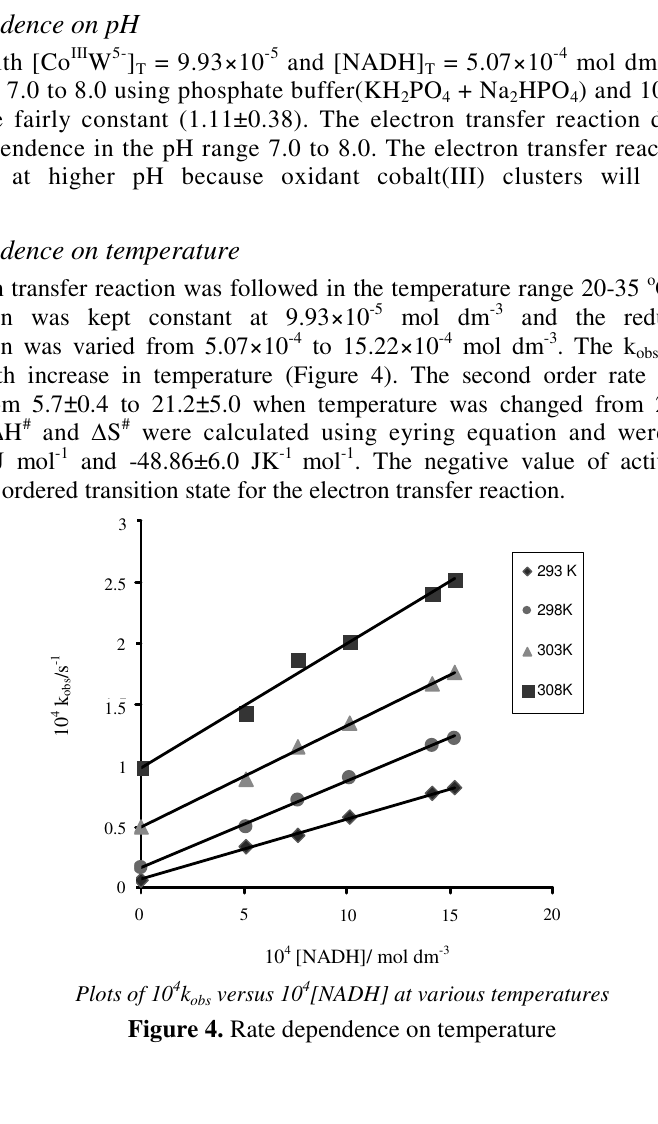
at different temperatures [Co III W 5- ] obs